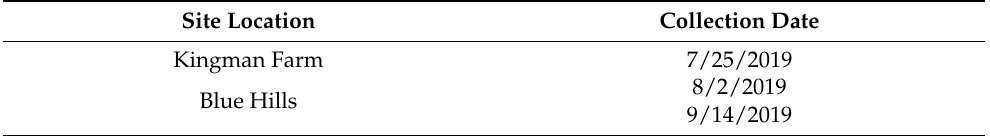
Table 2. Collection dates for the study